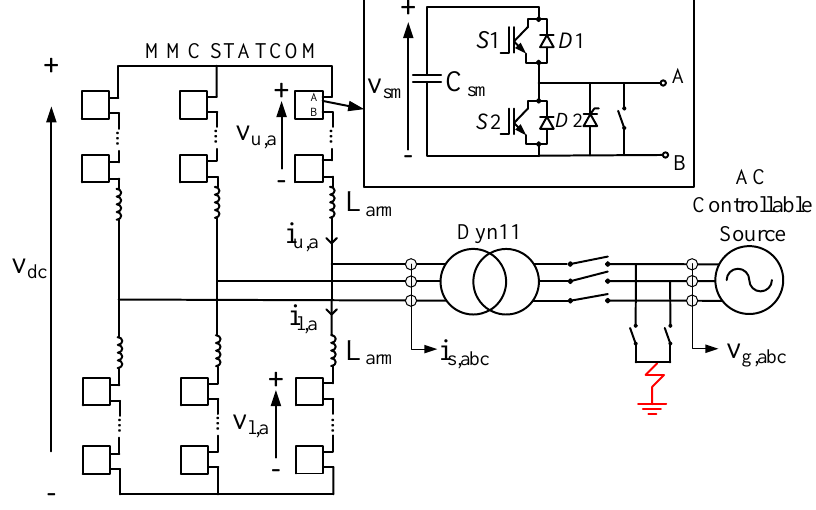
Figure 1. Modular Multilevel Converter (MMC)-based Static Synchronous Compensator (STATCOM)